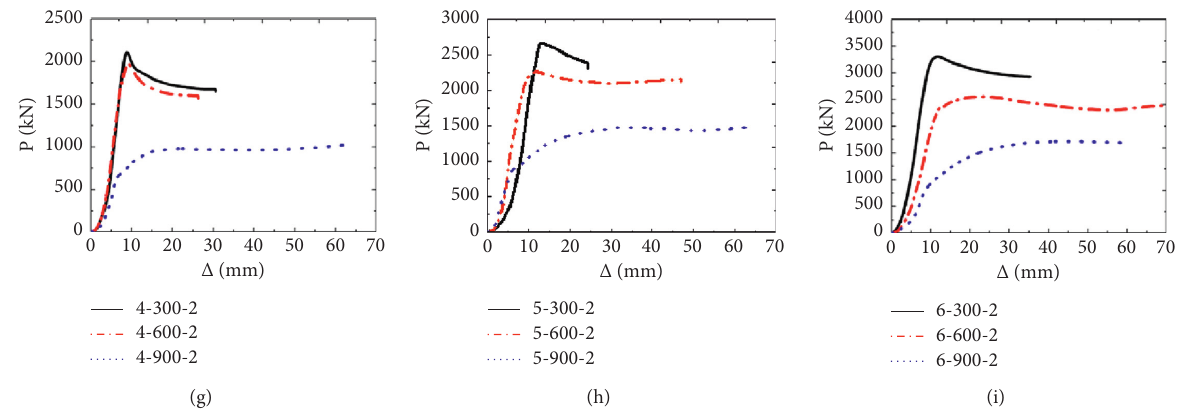
Figure 14: Different temperatures for the same duration and the same steel ratio. (a) 4mm thickness with 1 hour heating. (b) 5mm thickness with 1 hour heating. (c) 6 mm thickness with 1 hour heating. (d) 4mm thickness with 1.5 hours heating. (e) 5 mm thickness with 1.5 hours heating. (f) 6 mm thickness with 1.5 hours heating. (g) 4mm thickness with 2 hours heating. (h) 5mm thickness with 2 hours heating. (i) 6 mm thickness with 2 hours heating.